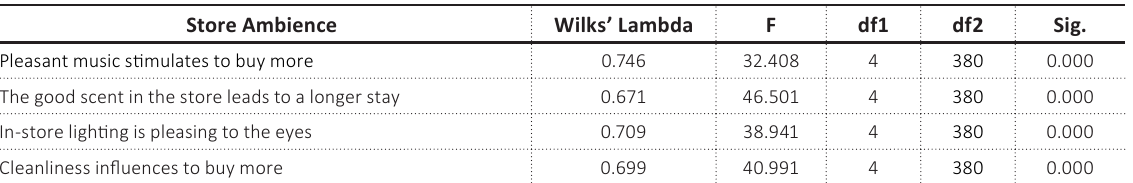
Table 4. Discriminant validity of store ambiance